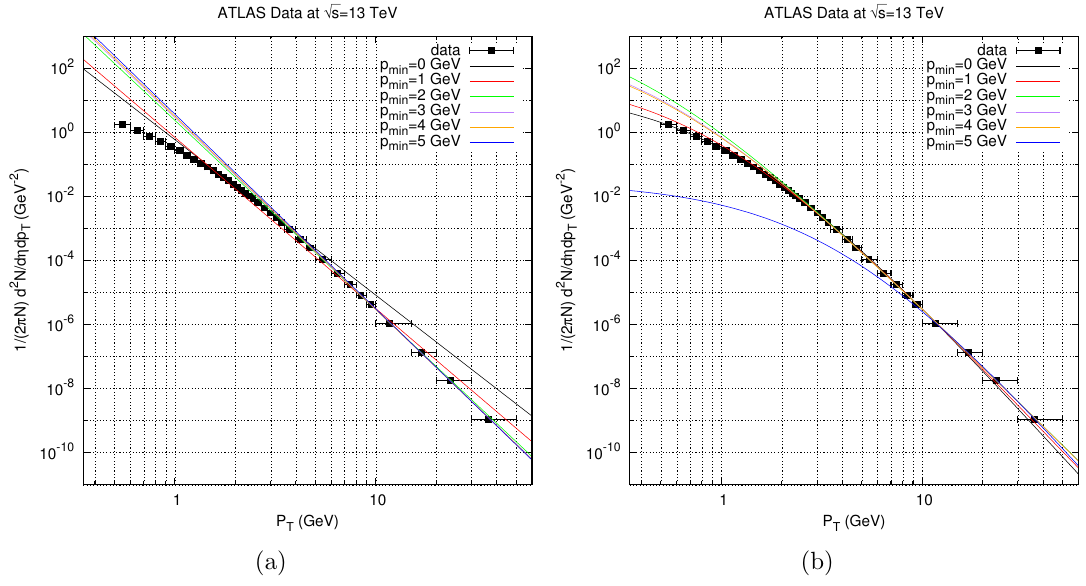
Figure 11. Fit of the two parameter ansatz in eq. (E.2) (left) and the three parameter ansatz in eq. (E.3) to the ATLAS dataset at p s = 13 TeV [93] with various data cuto(cid:11)s.